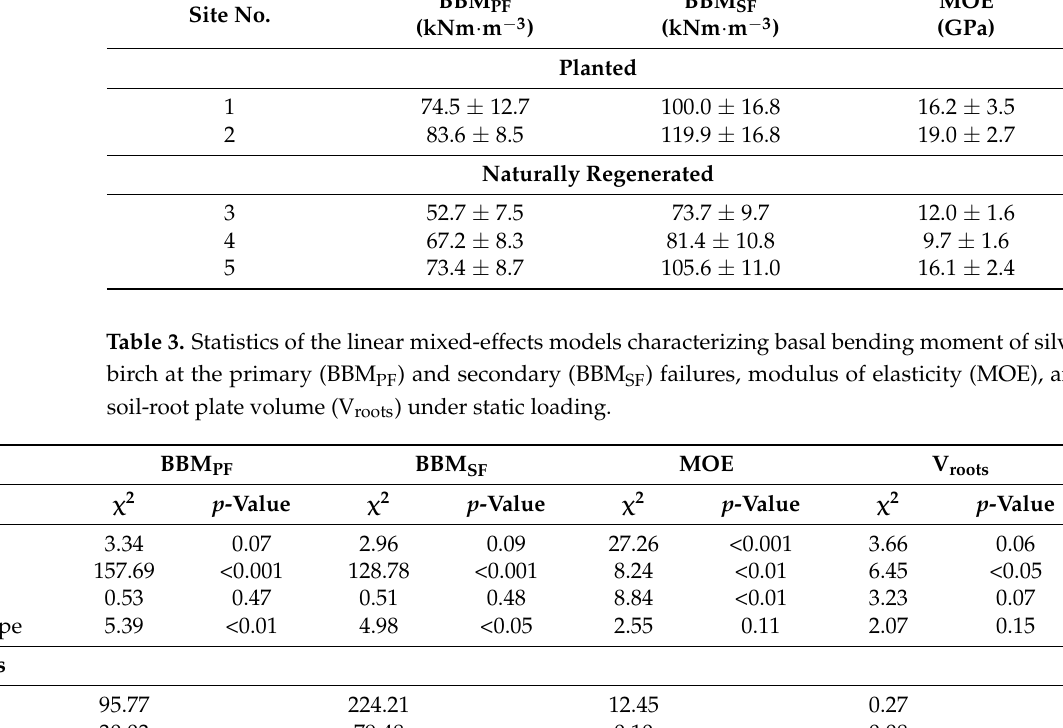
Table 2. Mean ( ± 95% confidence interval) relationship between basal bending moment and stem- wood volume (in m 3 ) of silver birch at primary (BBM PF ) and secondary failures (BBM SF ), the modulus of elasticity (MOE) and the number of trees with stem breakage in each sampled site. Site No.